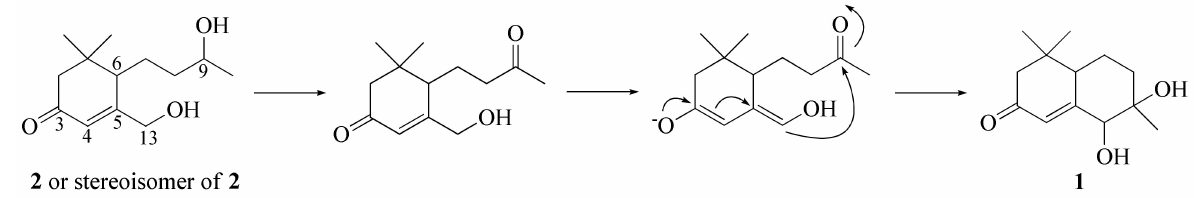
Figure 3. Key NOESY correlations of compound 1 .